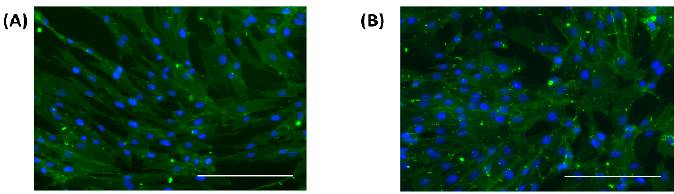
Figure 4. Immunofluorescent staining of CD90 (Thy-1) (green) in HDFa cultured in ( A ) Normal and ( B ) High glucose conditions. Cell nuclei (blue). Scale bar 200 µm.